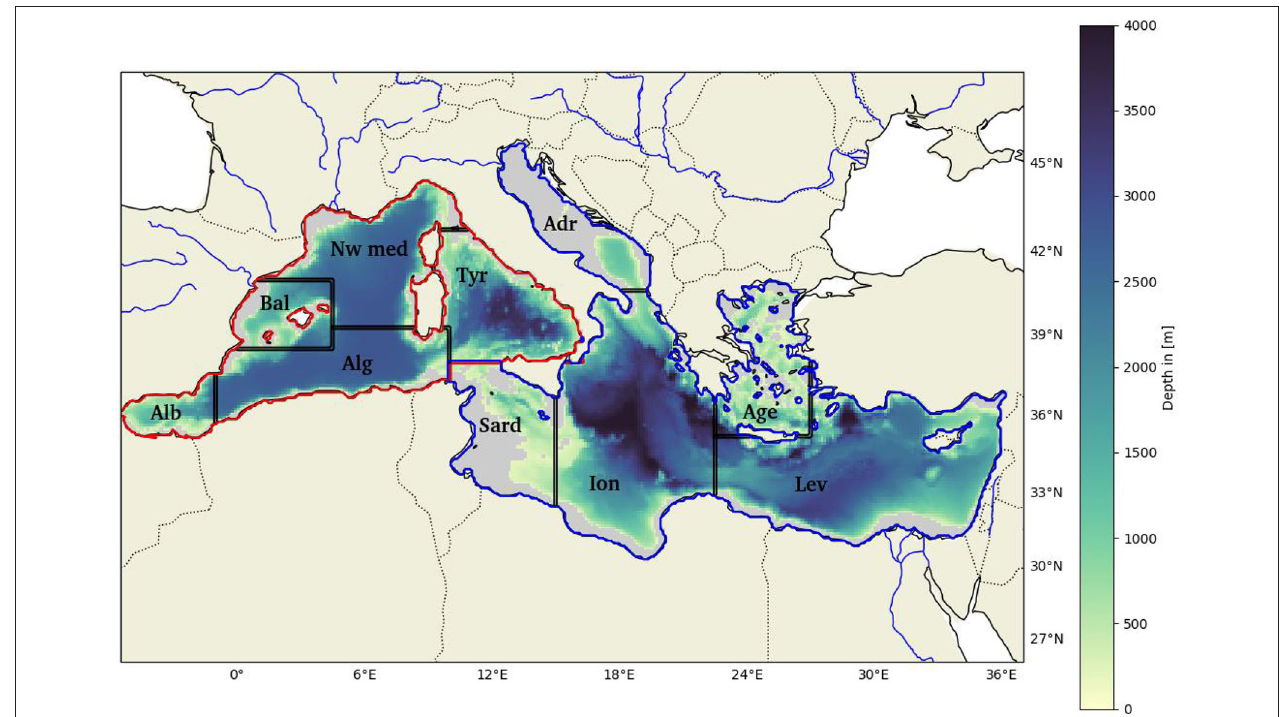
FIGURE 1 | Bathymetric map of the Mediterranean Sea; gray areas represent the regions with depths less than 200 m. The red outline shows the Western Basin and the blue one the Eastern Basin. Alb, Alboran Sea; Bal, Balearic Sea; Alg, Algerian Sea; Nw Med, North-western Mediterranean Sea; Tyr, Tyrrhenian Sea; Sard, Sardinia Channel; Adr, Adriatic Sea; Ion, Ionian Sea; Lev, Levantine Sea; and Age, Aegean